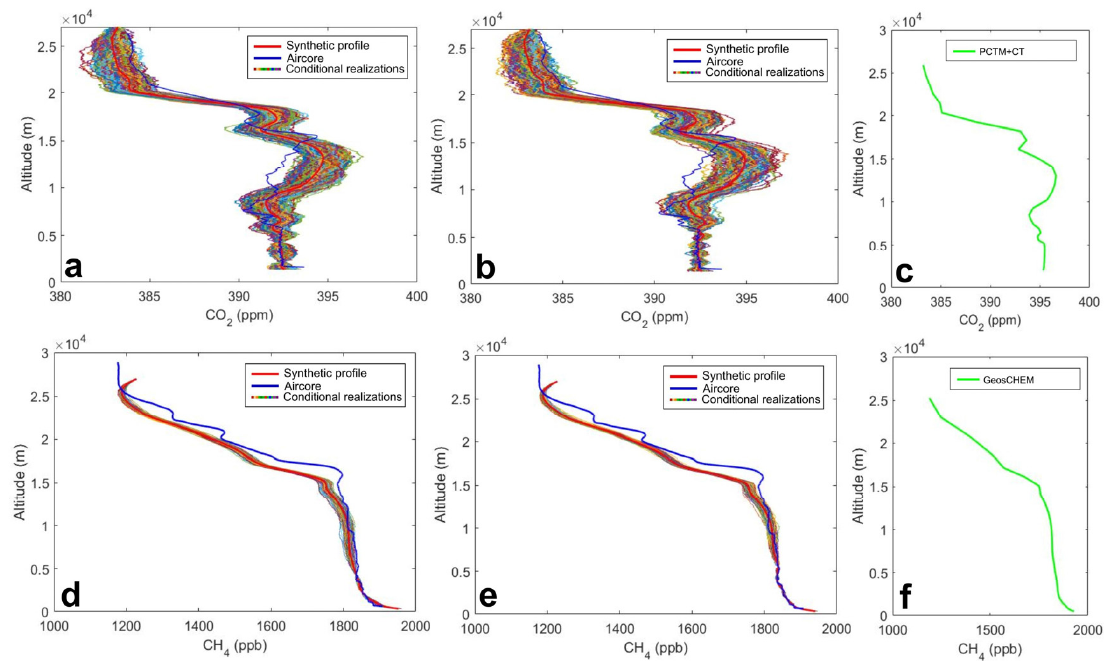
Figure 3. Reconstructed full vertical CO 2 ( a , b ) (15 August 2012) and CH 4 ( d , e ) (15 January 2012) profiles showing ensemble conditional realization cloud based on the imputed covariance parameters (sill 0.41 ppm 2 and 55 ppb 2 , range parameter 6000 m and 10,000 m, for CO 2 and CH 4 , respectively). Modeled profiles for CO 2 and CH 4 are given in ( c , f ), respectively. Red line represents the mean of 200 conditional realizations and the reconstructed full profile shape. The number of simulated flasks shown was two for ( a , c ), and six for ( c , d ).